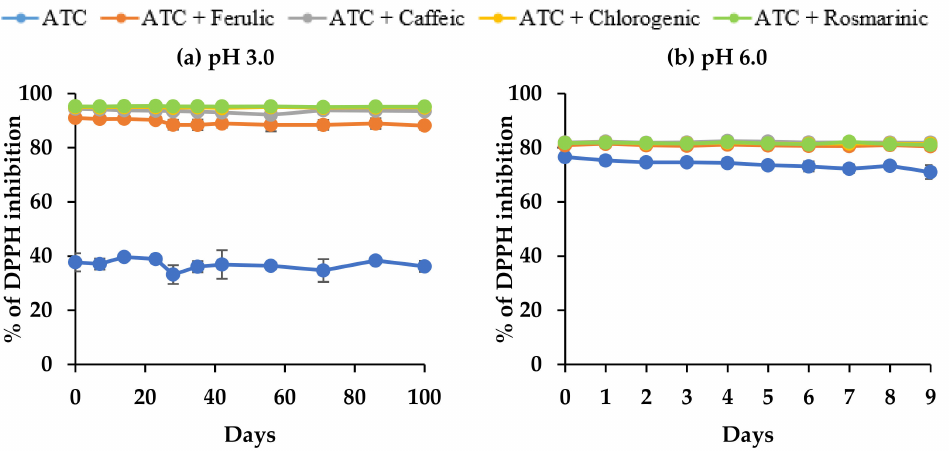
Figure 8. Antioxidant activities of anthocyanins from DBP extracts with phenolic acids as copigments during storage, as measured by a DPPH